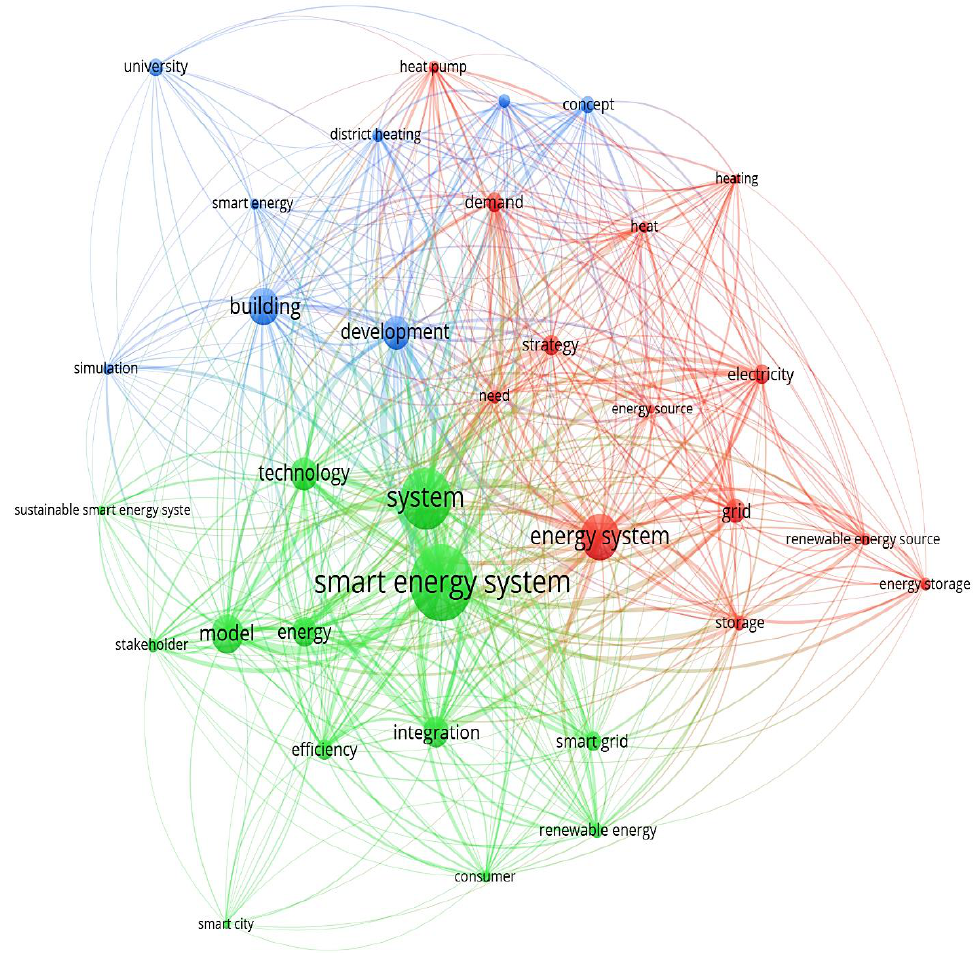
Figure 2. The VOS Viewer map of research trends in the selected papers from Scopus database.